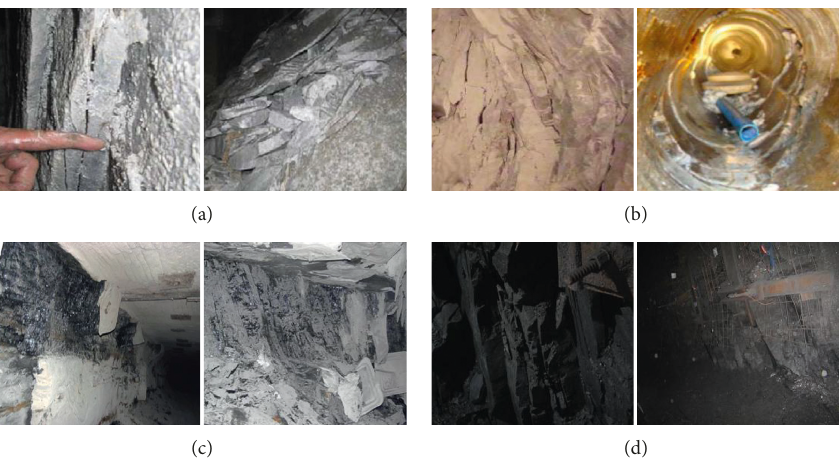
Figure 1: Phenomena of layer-crack structures in coal mines and tunnels. Layer-crack phenomenon in (a) tunnel A [11], (b) tunnel B [12], (c) coal mine A [13], and (d) coal mine